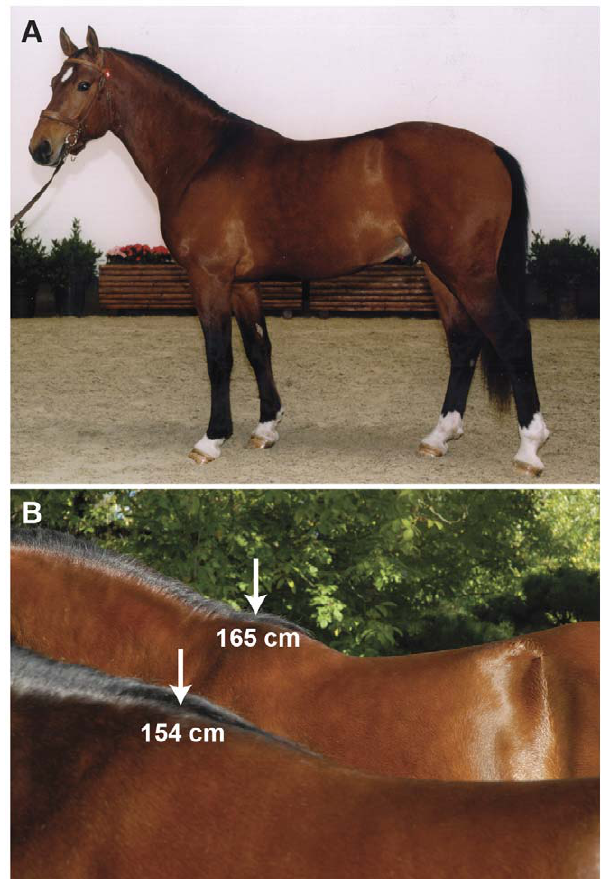
Figure 1. The Franches-Montagnes horse belongs to the type of light draft horse breeds and has its origins in Switzerland (A). Height at withers is one of 28 conformation traits, for which breeding values are estimated once a year (B). The breed standard calls for horses between 150–160 cm in size. The stallion in the background was the tallest horse in our study with a phenotypic height at withers of 165 cm. (Picture: Swiss National Stud Farm).